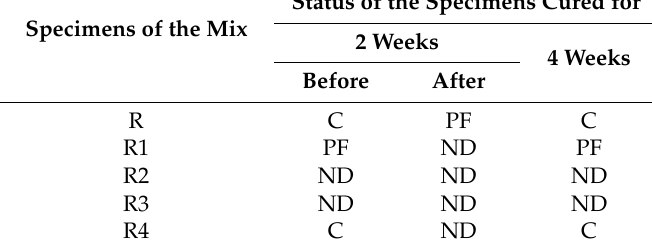
Table 3. Result of the water soaking test of the cured specimens of different mixes before and after treatment. Status of the Specimens Cured for Specimens of the Mix 2 Weeks 4 Weeks Before After R C PF C R1 PF ND PF R2 ND ND ND R3 ND ND ND R4 C ND